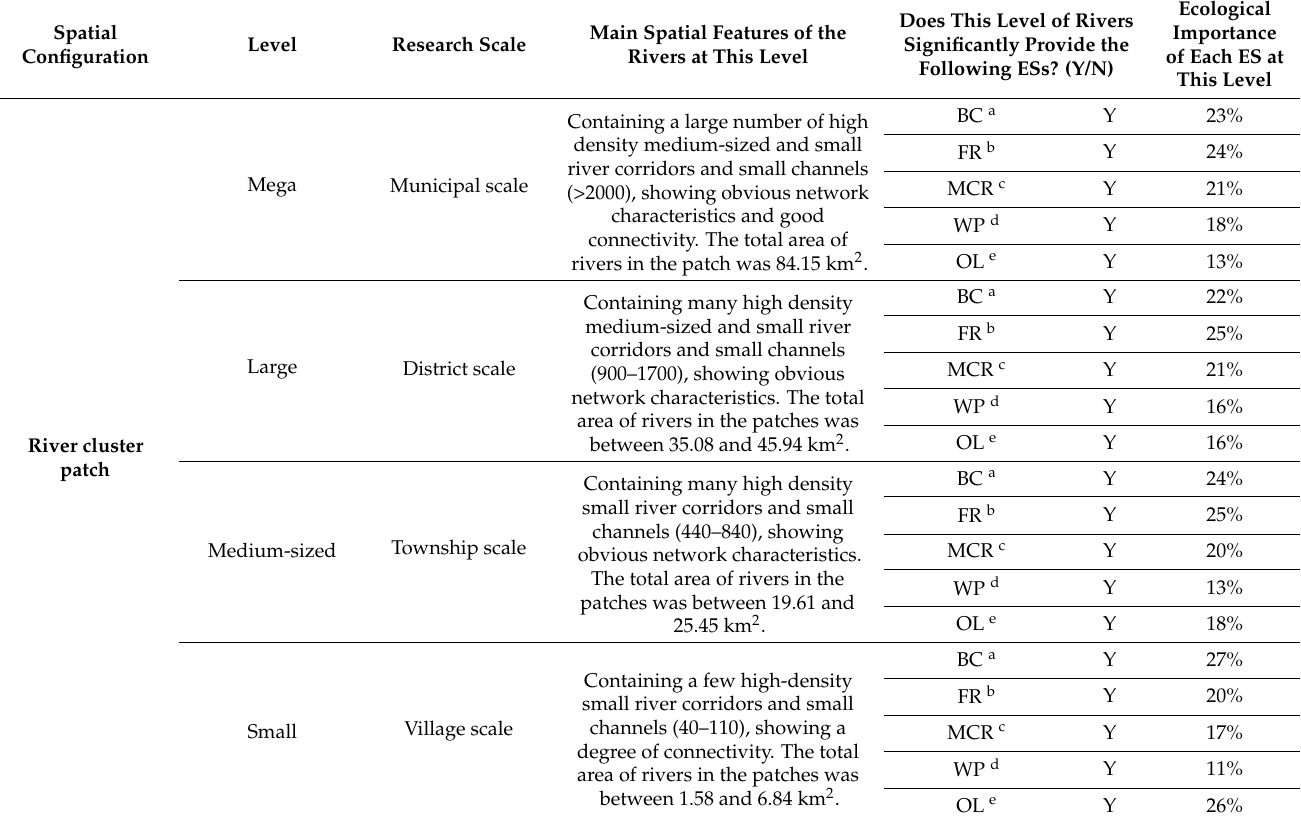
Table A3. Types and ecological importance weights of ES from all-level water linear spaces based on expert